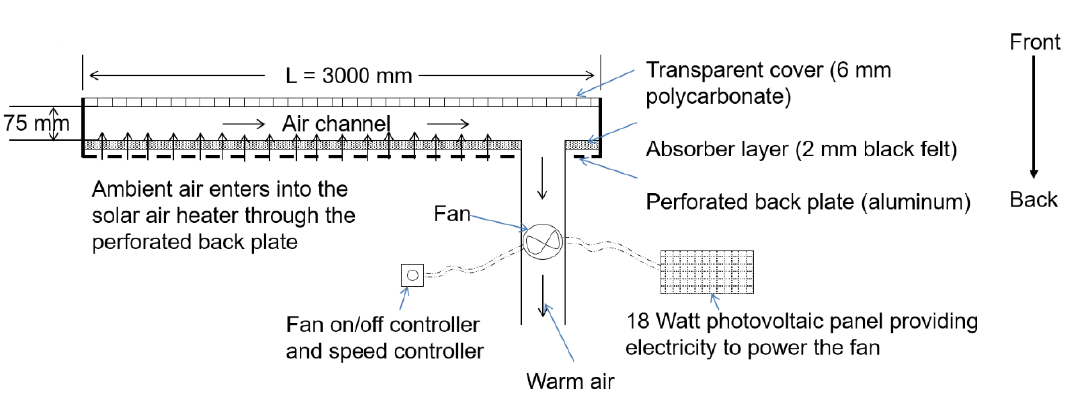
Figure 2. Schematic view of the studied solar air heater.